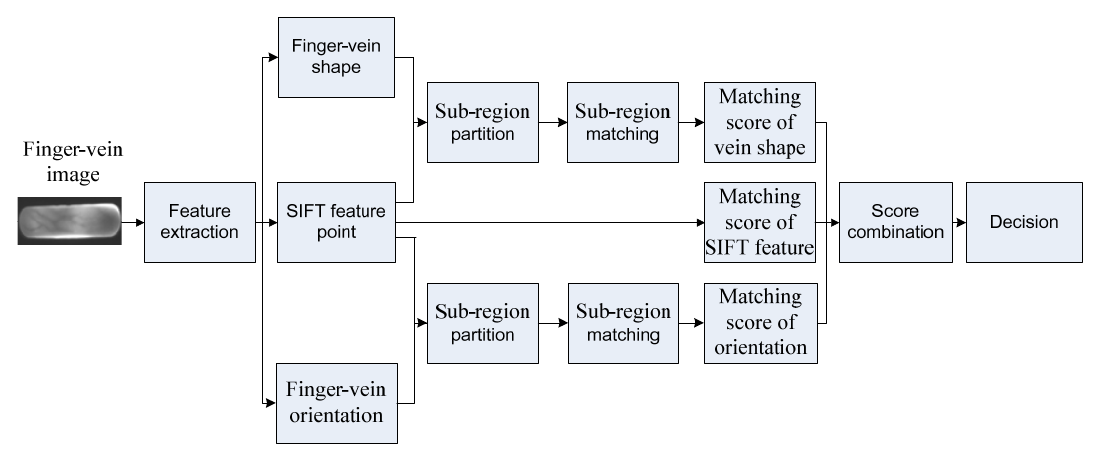
Figure 1. Block diagram for personal identification using finger-vein